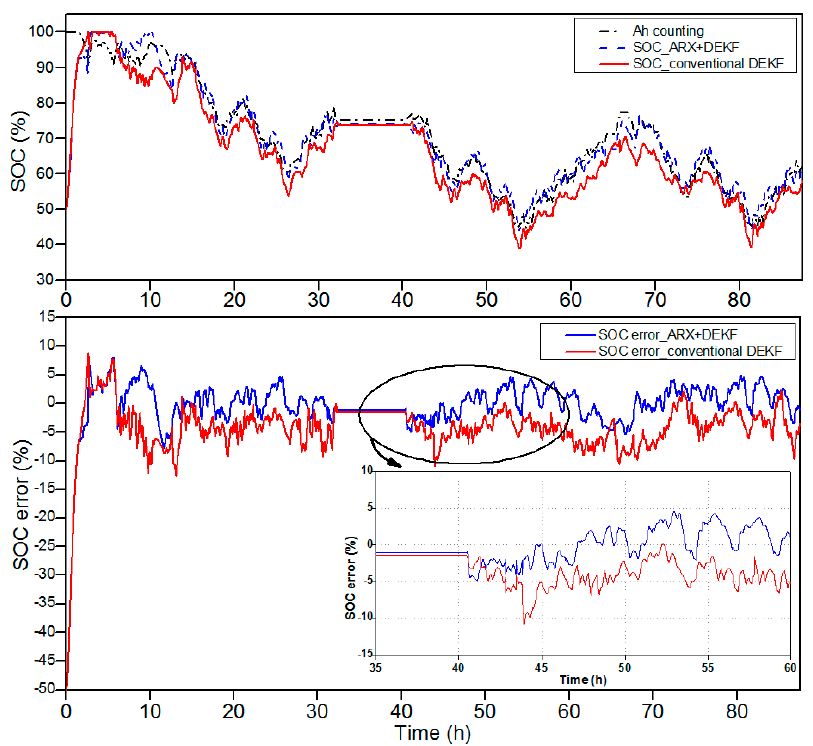
Figure 8. Comparison of the SOC estimation for the aged battery (75.6% SOH) by the proposed ARX-DEKF and conventional DEKF method.